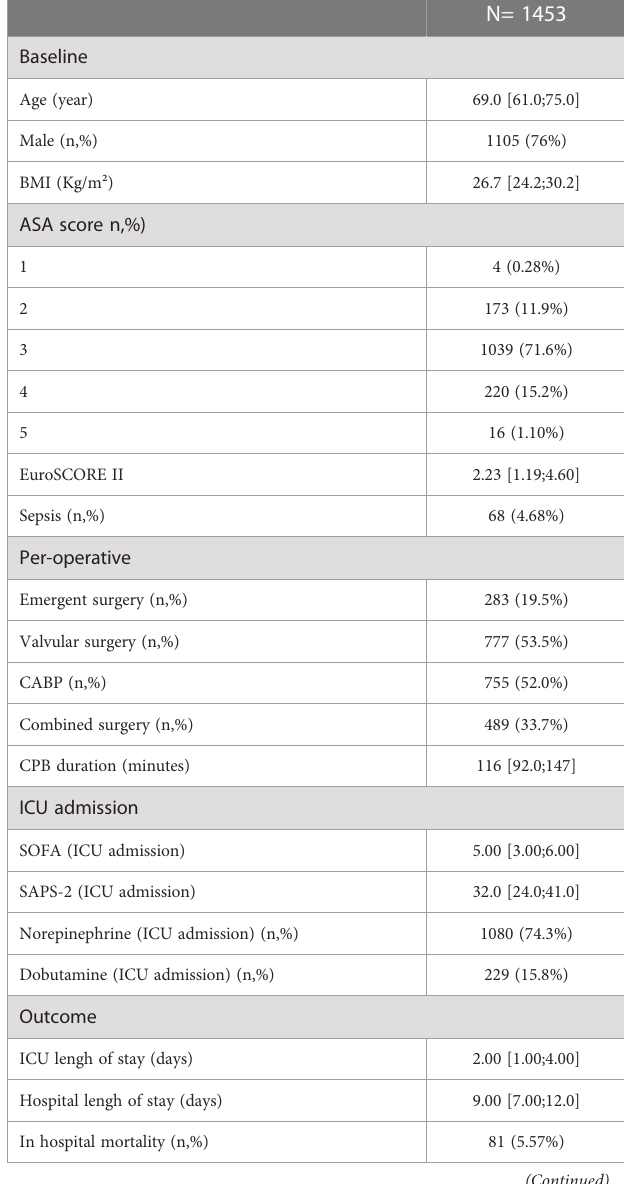
TABLE 1 Characteristics of the